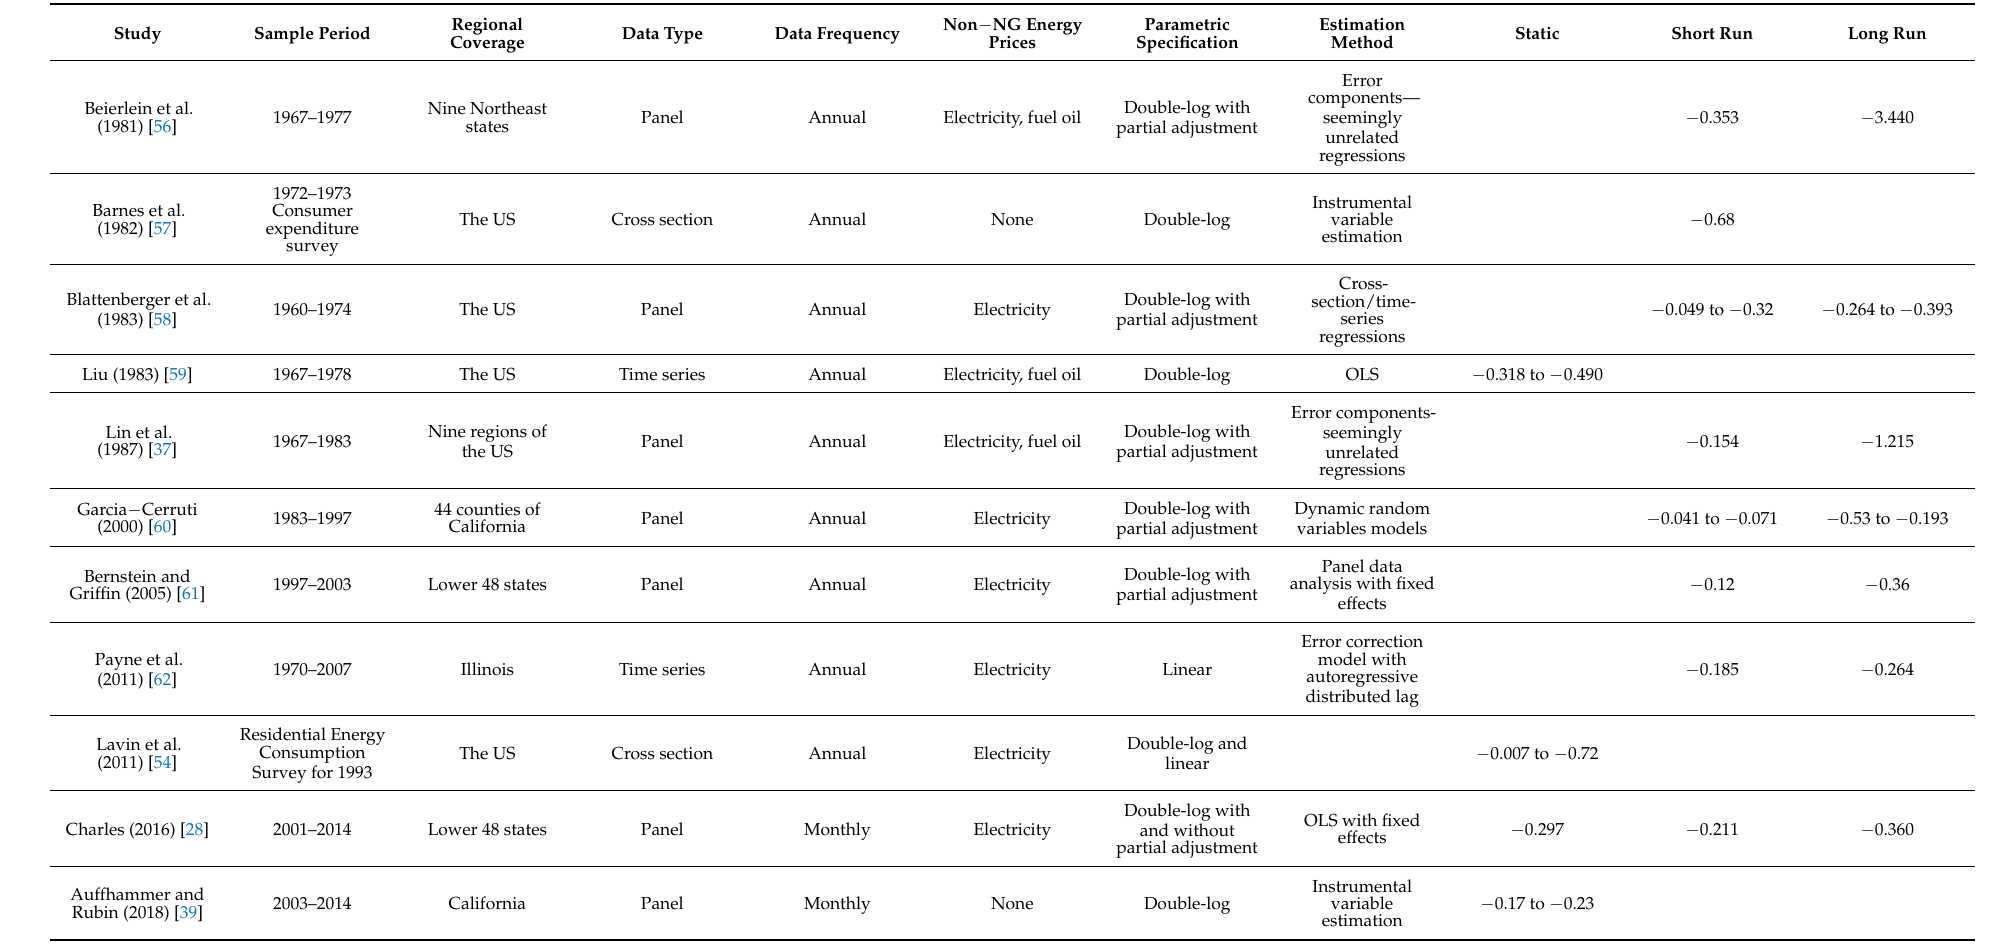
Table A1. Own-price elasticity estimates from thirteen selected studies of residential demand for natural gas (NG) in the